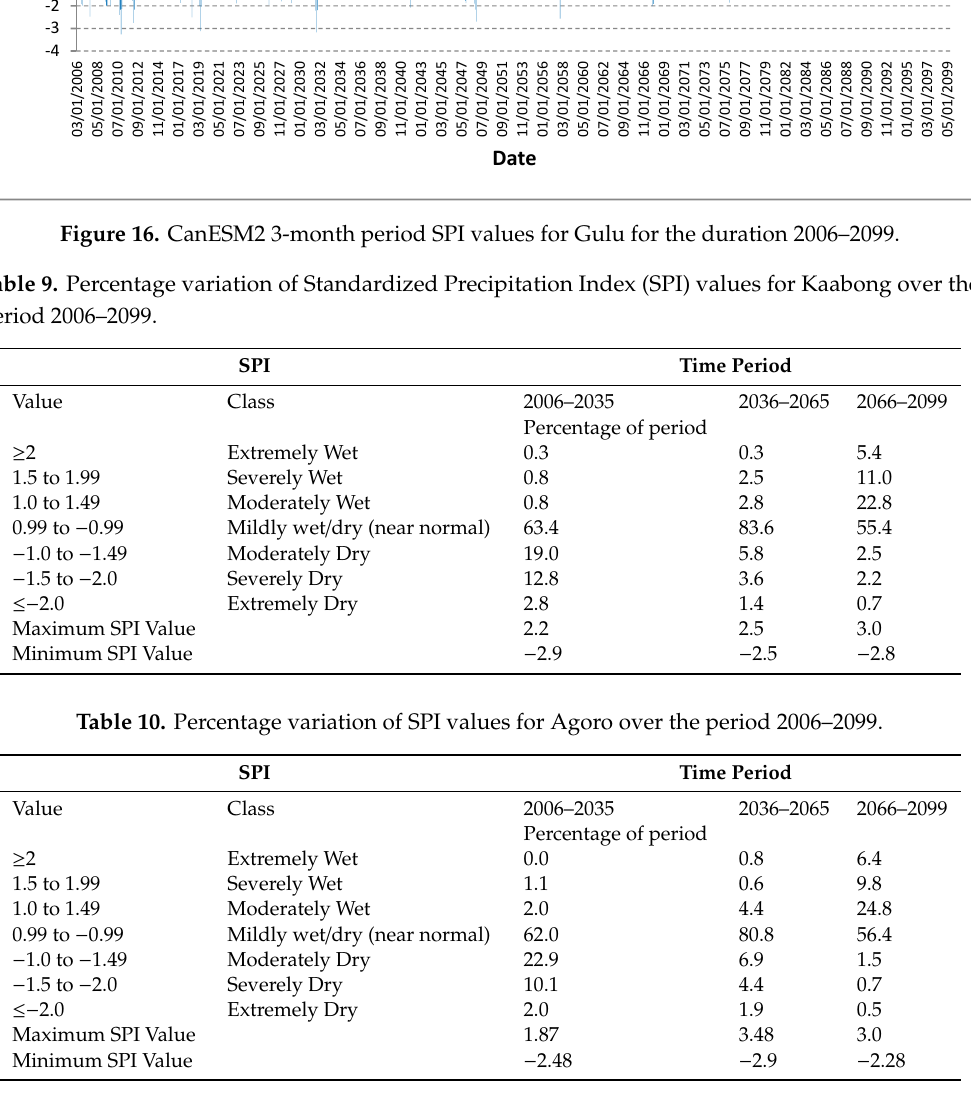
Table 10. Percentage variation of SPI values for Agoro over the period 2006–2099.